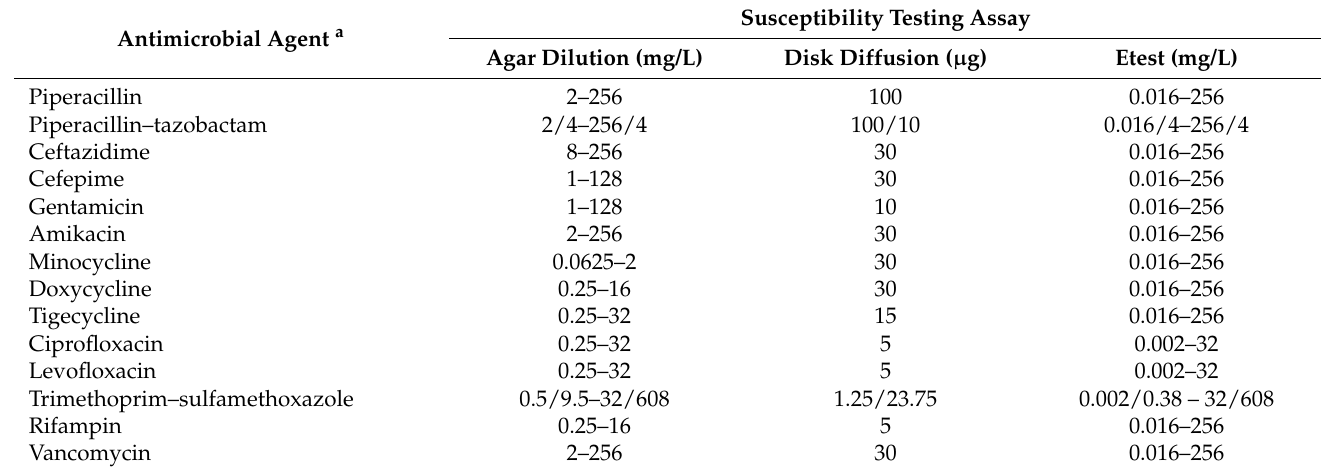
Table 1. The ranges of antimicrobial concentrations used in this